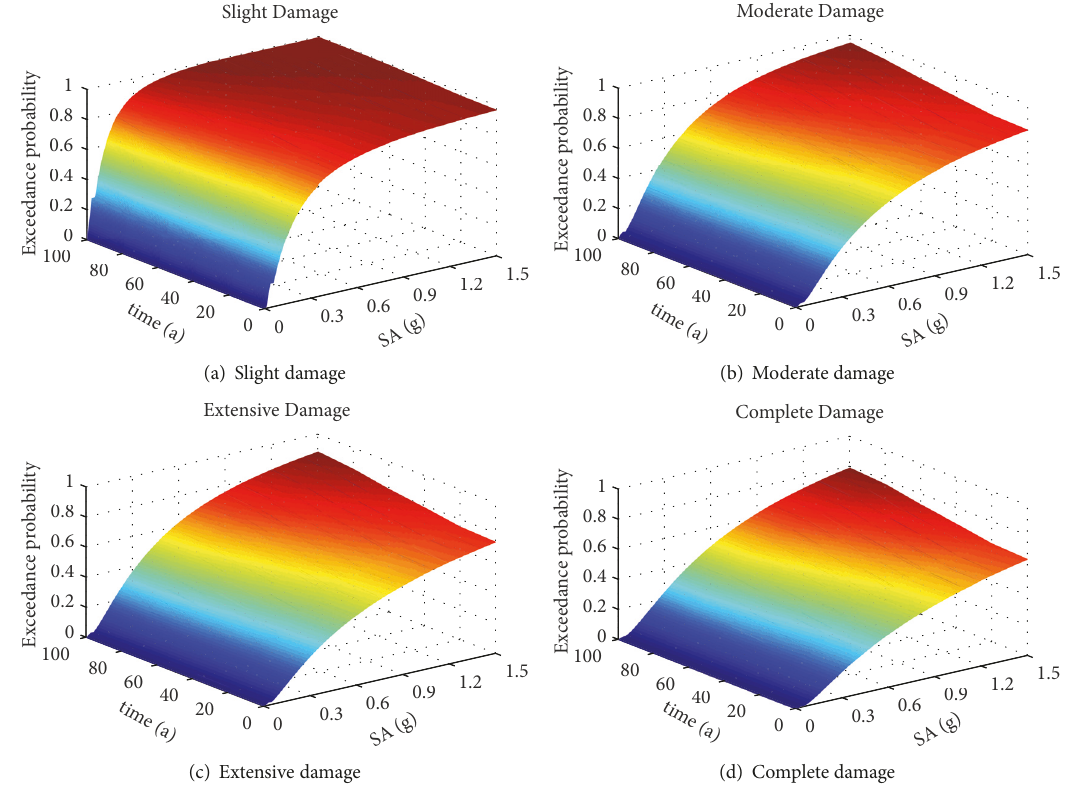
Figure 16: The vulnerability surfaces of 1 # bearing under different damage